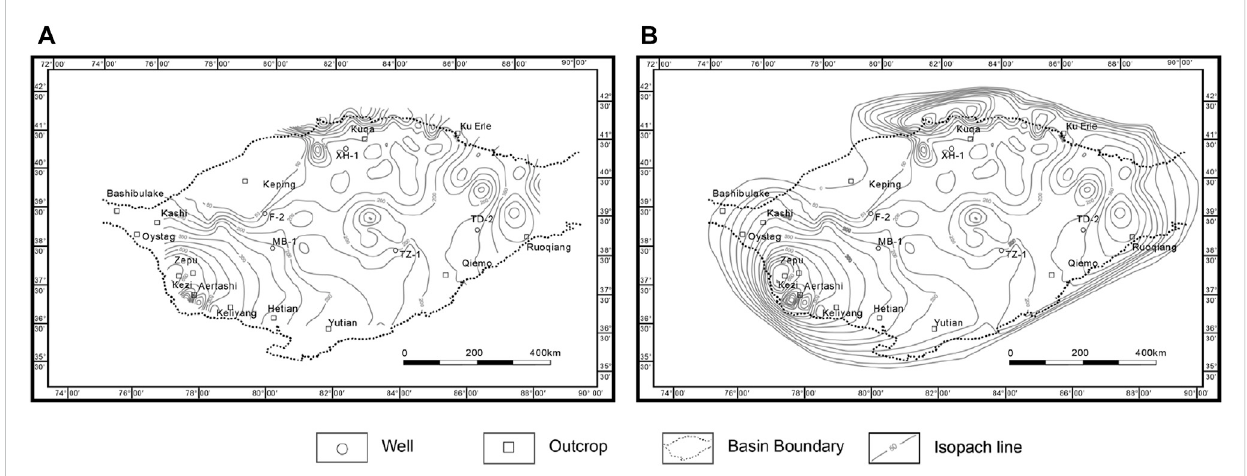
FIGURE 3 Schematicdiagramsshowingthestepsofrestoringtheoriginalthicknessmap,takingthelatePaleogenerestoration asanexample. (A) :Theresidual thickness map of residual basin; (B) the pre-shortening original thickness map of the residual basin; thickness map contours show the depth (m) of the Upper Eocene to Oligocene in the Tarim